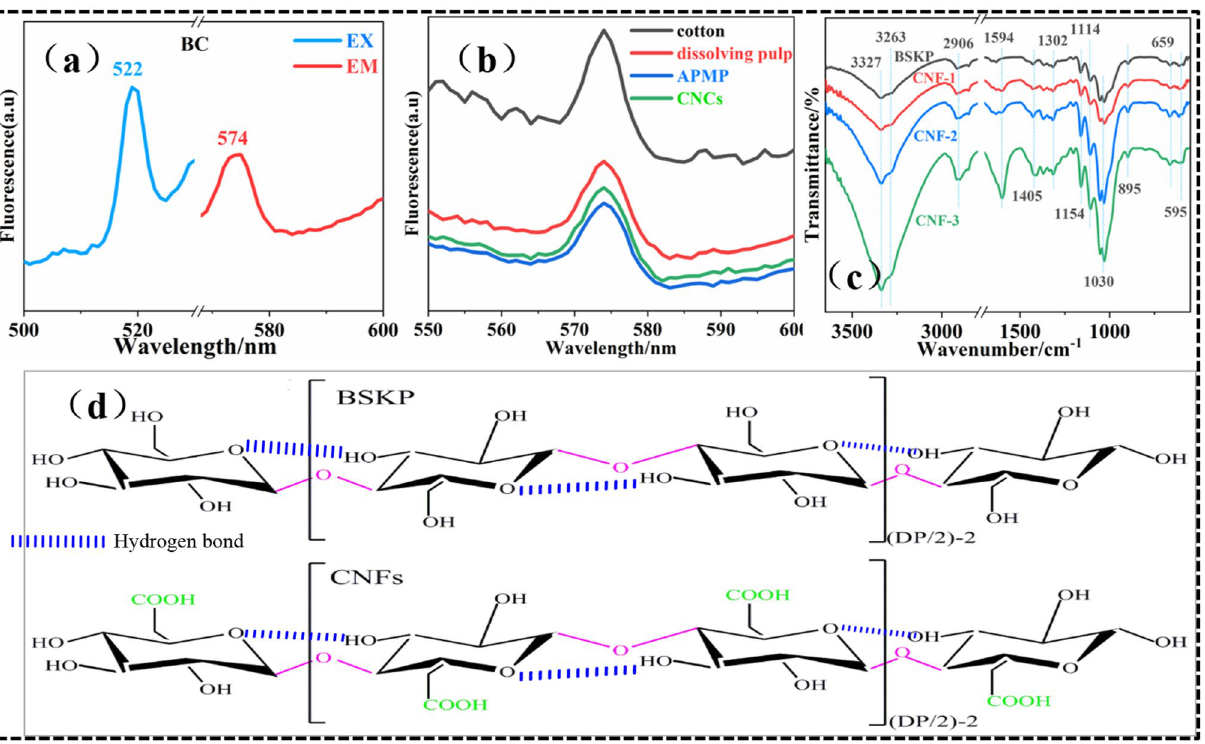
Figure 3. ( a ) Fluorescence spectrum of BC. ( b ) Comparison of fluorescence properties of cotton, dissolving pulp, APMP, CNCs. ( c ) Comparison of FTIR spectra of BSKP, CNF-1, CNF-2 and CNF-3. ( d ) Schematic diagram of the molecular chain structure of BSKP and